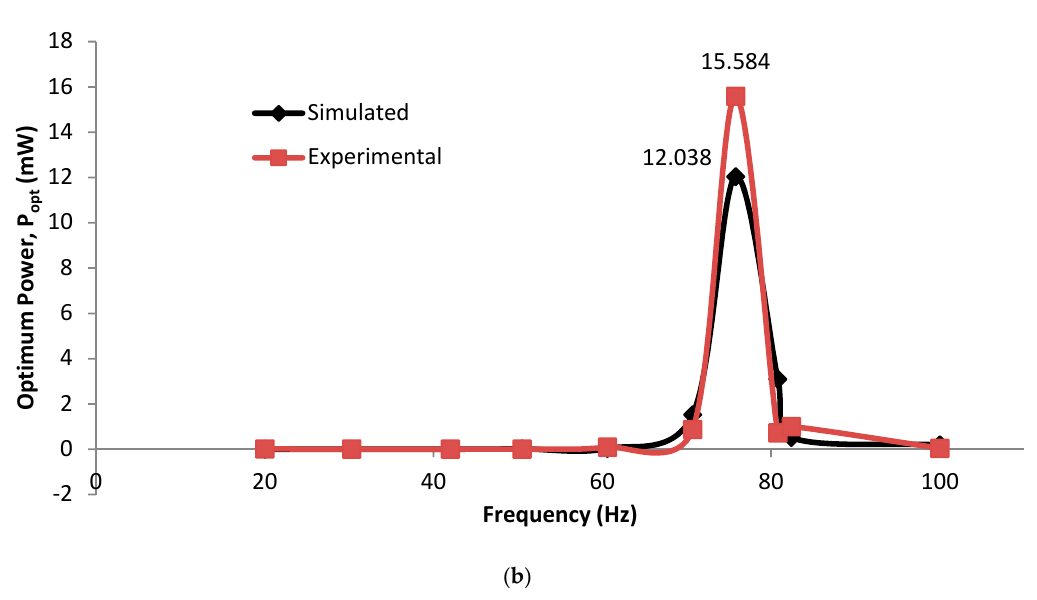
Figure 22. Optimum power against ( a ) wind speed ( b ) frequency.